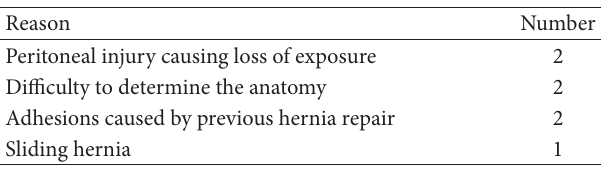
Table 1: Causes for conversion.